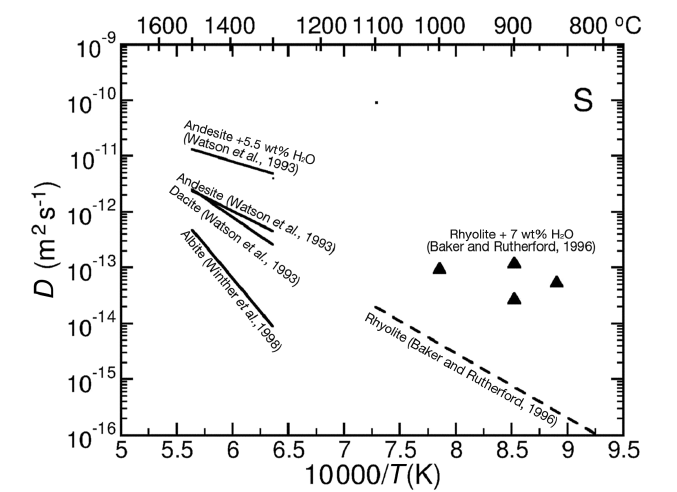
Fig. 4. Diffusion of sulfur in magmatic silicate